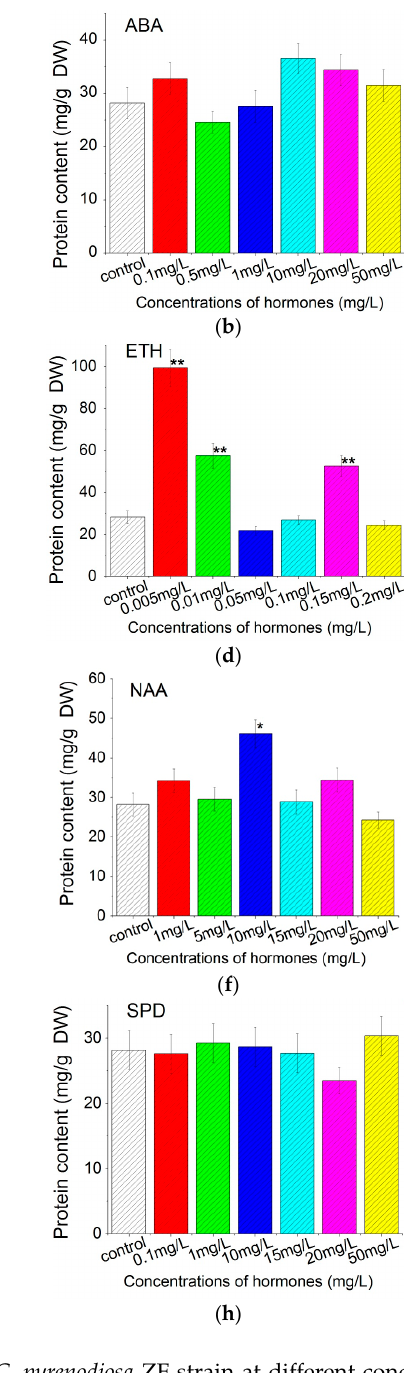
Figure 3. The total soluble protein contents of C. pyrenodiosa ZF strain at different concentrations of plant growth regulators: ( a ) 6-BA treatments; ( b ) ABA treatments; ( c ) EBR treatments; ( d ) ETH treatments; ( e ) GA 3 treatments; ( f ) NAA treatments; ( g ) SA treatments; ( h ) SPD